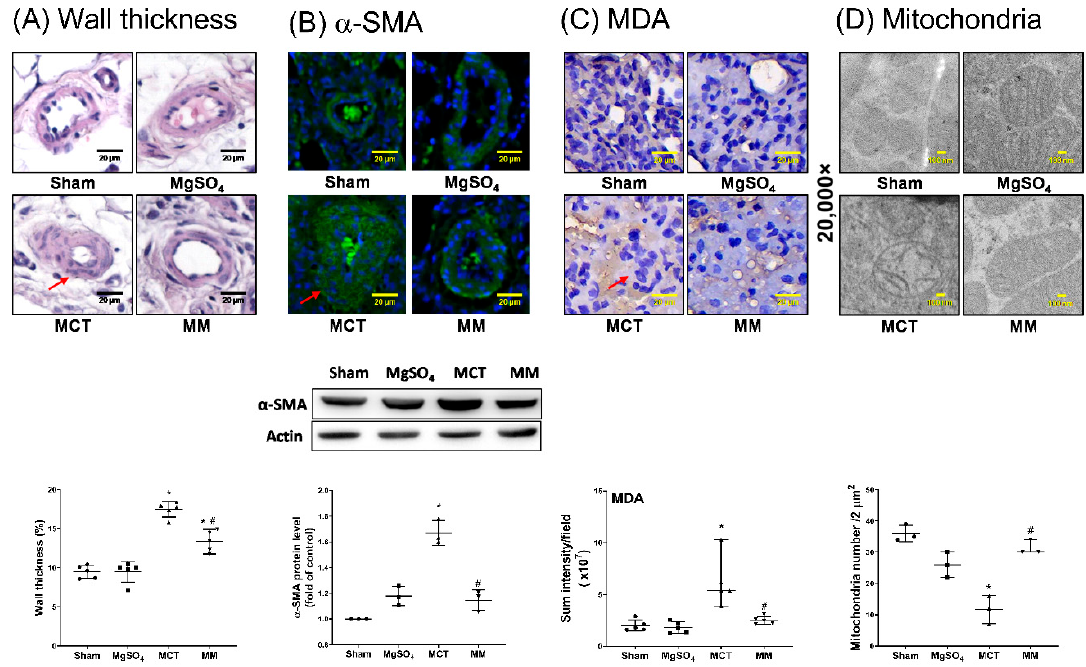
Figure 2. Magnesium sulfate (MgSO 4 ) mitigates monocrotaline-induced pulmonary artery remodeling and lipid peroxidation in the lung tissues, and monocrotaline-induced mitochondrial injury in pulmonary arteries. ( A ) Representative microscopic images of the pulmonary arteries in the lung tissues stained with hematoxylin and eosin (200×). The red arrow indicates the representative image of thickened pulmonary arteries. Wall thickness ratios of pulmonary arteries are presented. ( B ) Representative microscopic images of α -smooth muscle actin ( α -SMA, green fluorescence) and nuclei (blue fluorescence) of the pulmonary arteries in the lung tissues through immunofluorescence staining assay (200×). Representative gel photography of α -SMA and actin (internal standard) in the lung tissues were obtained through immunoblotting assays. The red arrow indicates the representative image of increased α -SMA expression. Quantitative sum intensities of α -SMA and relative α -SMA/actin band densities are presented. ( C ) Representative microscopic images of malondialdehyde (MDA, the end product of lipid peroxidation) in the lung tissues observed through immunohistochemistry staining assay (200×). The red arrow indicates a representative image of MDA with brown staining. Quantitative sum intensities of MDA are presented. ( D ) Representative transmission electron microscopic images of mitochondria in the pulmonary artery (20,000×). Mean intact mitochondria numbers (per 2 μ m 2 ) are presented. Sham: normal saline group. MgOS 4 : MgSO 4 (100 mg/kg/day) group. MCT: monocrotaline (60 mg/kg) group. MM: monocrotaline (60 mg/kg) plus MgSO 4 (100 mg/kg/day) group. Data are expressed as median (range). Data of the wall thickness ratio,